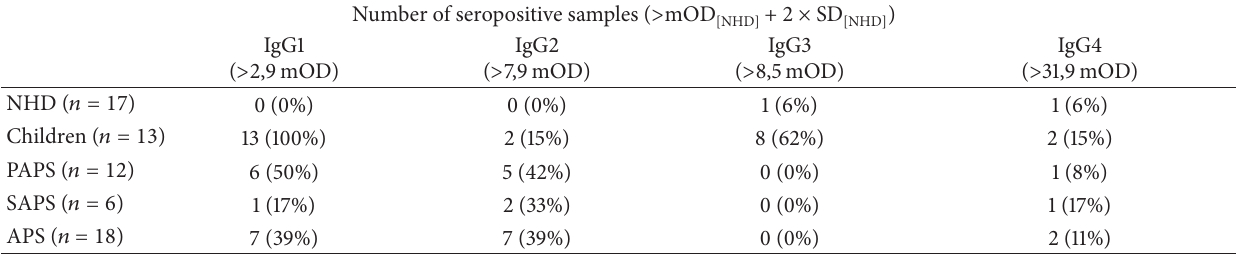
Table 4: Number (frequency) of seropositive samples of the anti- 𝛽 2GP1-IgG subclasses.